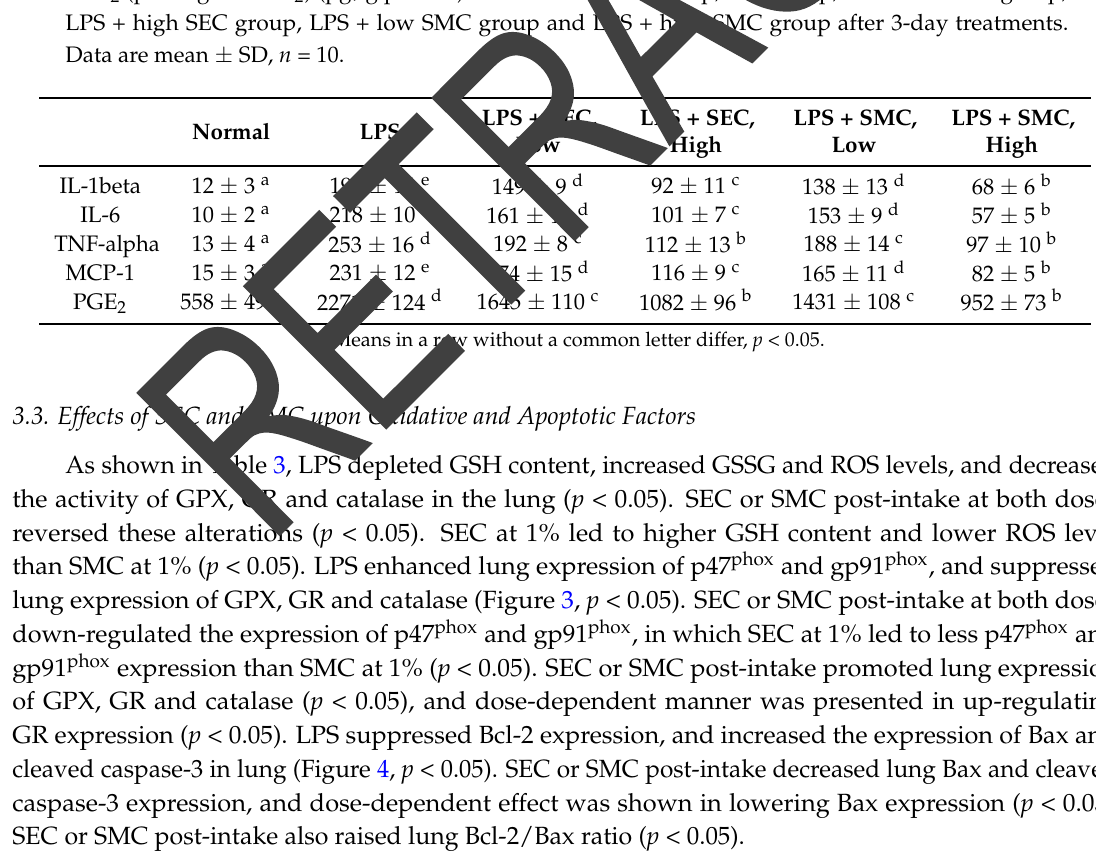
Figure 2. Lung expression of COX-2, NF- κ B and MAPK of mice in normal group, LPS group, LPS + low SEC group, LPS + high SEC group, LPS + low SMC group and LPS + high SMC group after 3-day treatments. Data are mean ± SD, n = 10; a − e Means among bars without a common letter differ, p < 0.05. Table 2. Lung level of IL-1beta (interleukin) (pg/mg protein), IL-6 (pg/mg protein), TNF-alpha (tumor necrosis factor) (pg/mg protein), MCP-1 (pg/mg protein) (monocyte chemoattractant protein) and PGE 2 (prostaglandin E 2 ) (pg/g protein) of mice in normal group, LPS group, LPS + low SEC group, LPS + high SEC group, LPS + low SMC group and LPS + high SMC group after 3-day treatments. Data are mean ± SD, n =